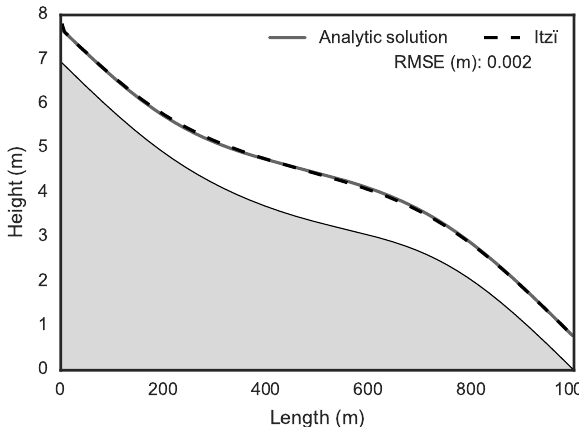
Figure 3. Comparing Itzï with an analytic solution (the case of the one-dimensional MacDonald long